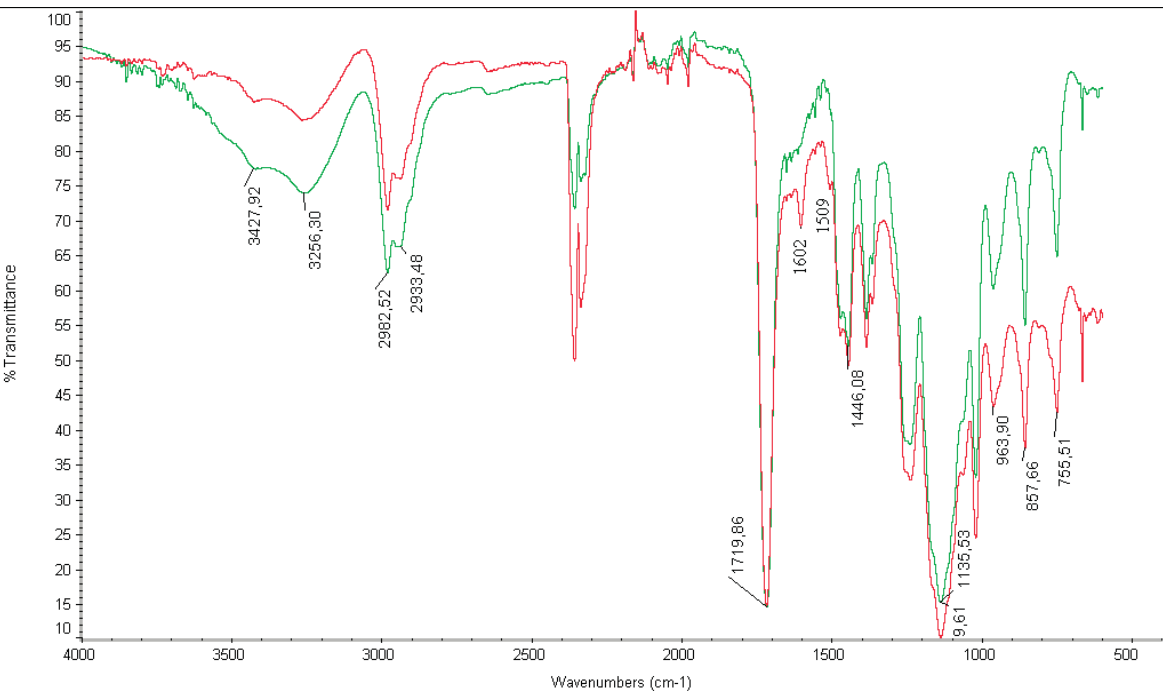
Figure 1. Micro-IR spectra of Pd-pol before ( red line ) and after ( green line ) 7 cycles of a NaBH 4 reduction of